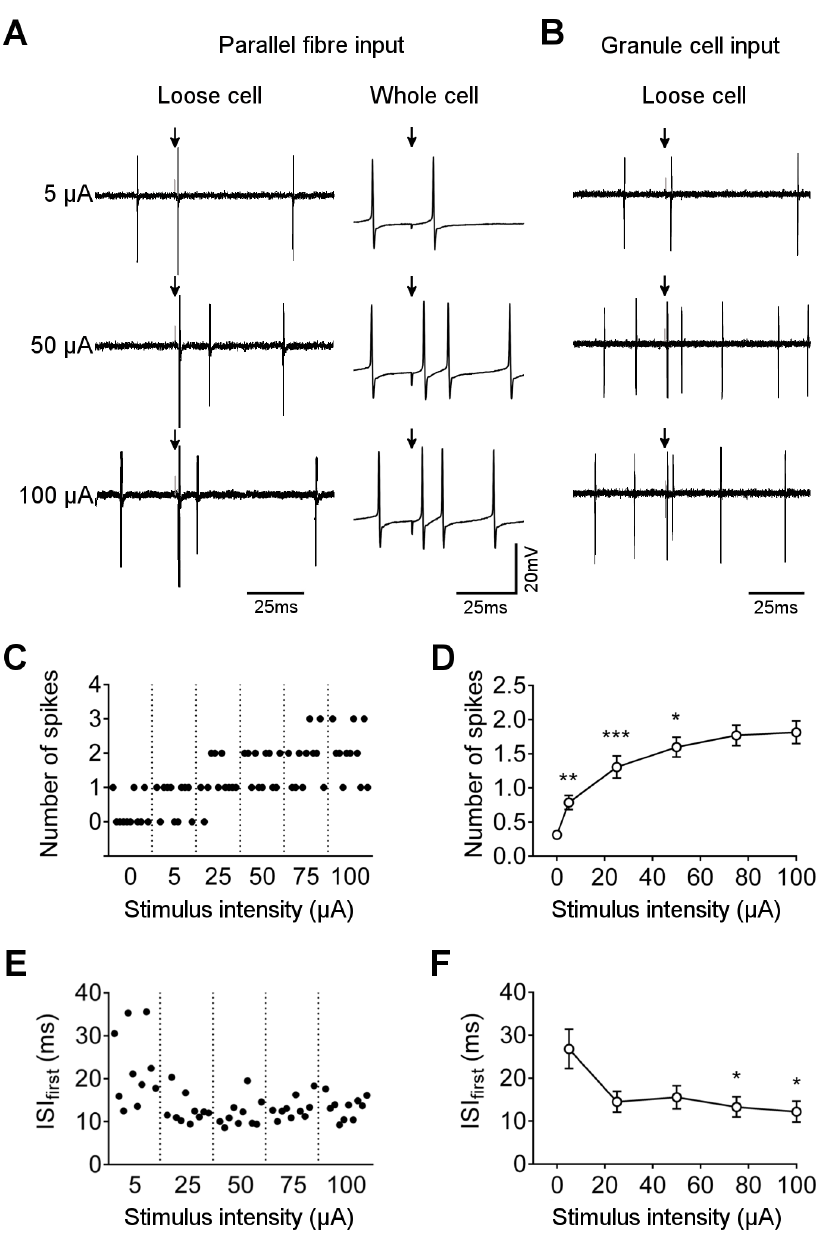
Figure 3. Effect of stimulus intensity on number of post-stimulus spikes. A) Loose cell (left panels) and whole cell (right panels) recordings from representative Purkinje neurons during stimulation in the molecular layer (arrow) at increasing intensities (as indicated). B) Loose cell recordings from representative cells during stimulation in the granular layer, at the same intensities as shown for molecular layer. C) Raster plot of number of post-stimulus spikes for 10 representative responses at each stimulus intensity. Note that 0 m A corresponds to sampling from the record in the absence of stimulus but with the same frequency as during stimulation, to give a measure of the probability of one or more spikes occurring within the sampling window by chance. D) Mean 6 s.e.m. number of post-stimulus spikes against stimulus intensity (n=15 cells). **p=0.0053, ***p=0.0009, *p=0.0383, for comparison of mean to preceding (lower) stimulus intensity. Multiple comparisons ANOVA with Tukey’s test for pairs (adjusted p values). E) Raster plot of 10 representative interspike intervals, for first pair of spikes, at each stimulus intensity. F) Mean 6 s.e.m. of first interspike interval against stimulus intensity (n=15 cells). *p , 0.02 compared to 5 m A. Multiple comparisons ANOVA with Tukey’s test for pairs.